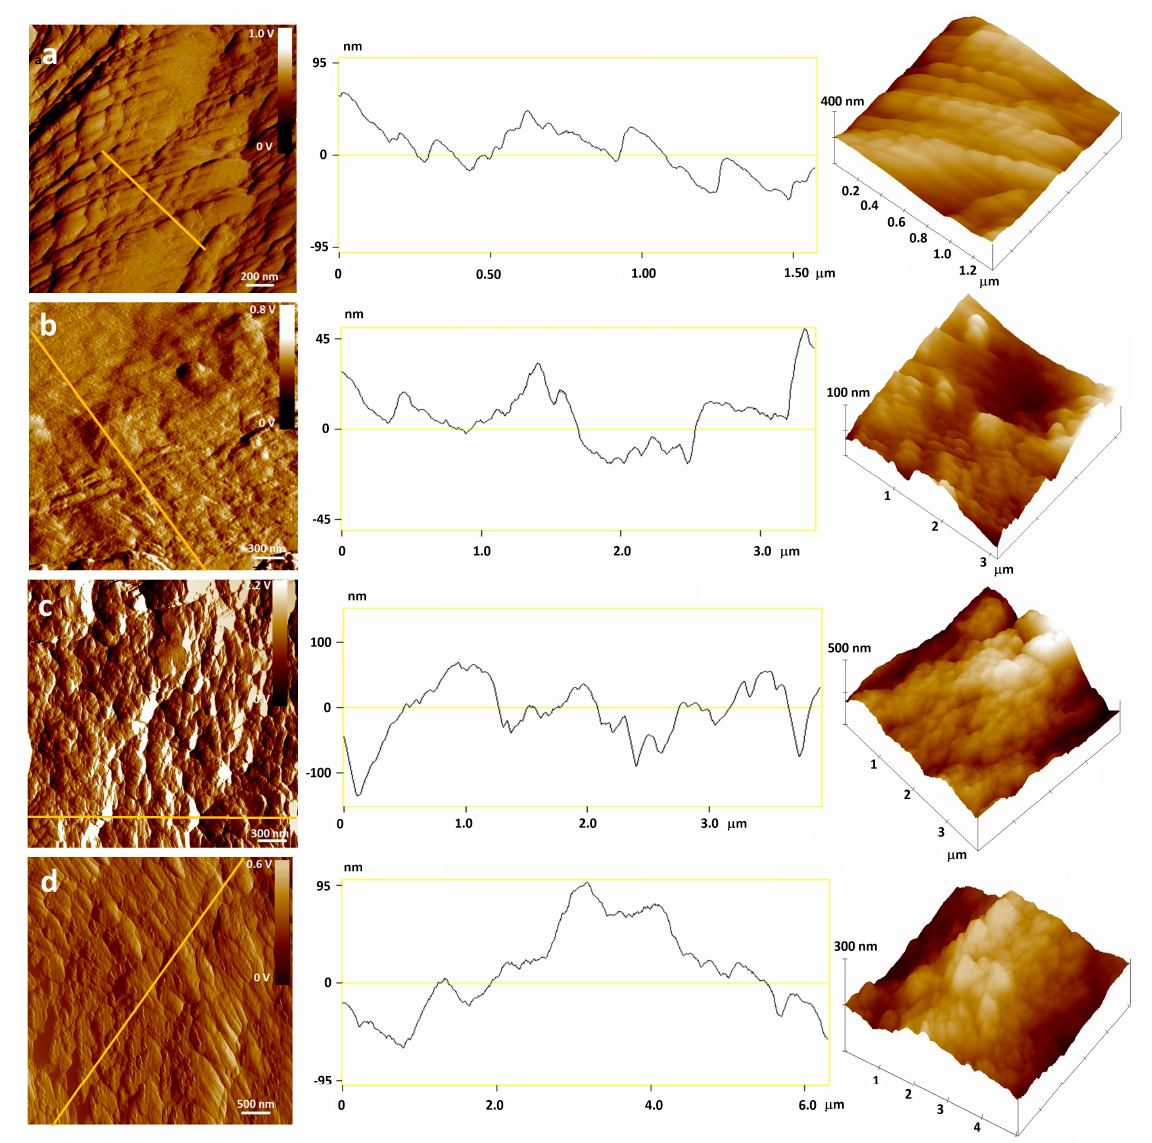
Figure 5. AFM amplitude image ( left ), section analysis profile along the labeled line ( middle ) and 3D-topographic images of height data — top view ( right ) of microparticles loaded with rosemary extract: ( a ) Alg, ( b ) Alg/Z, ( c ) Alg/HPMC, and ( d ) Alg/Z/HPMC. Bars are indicated.